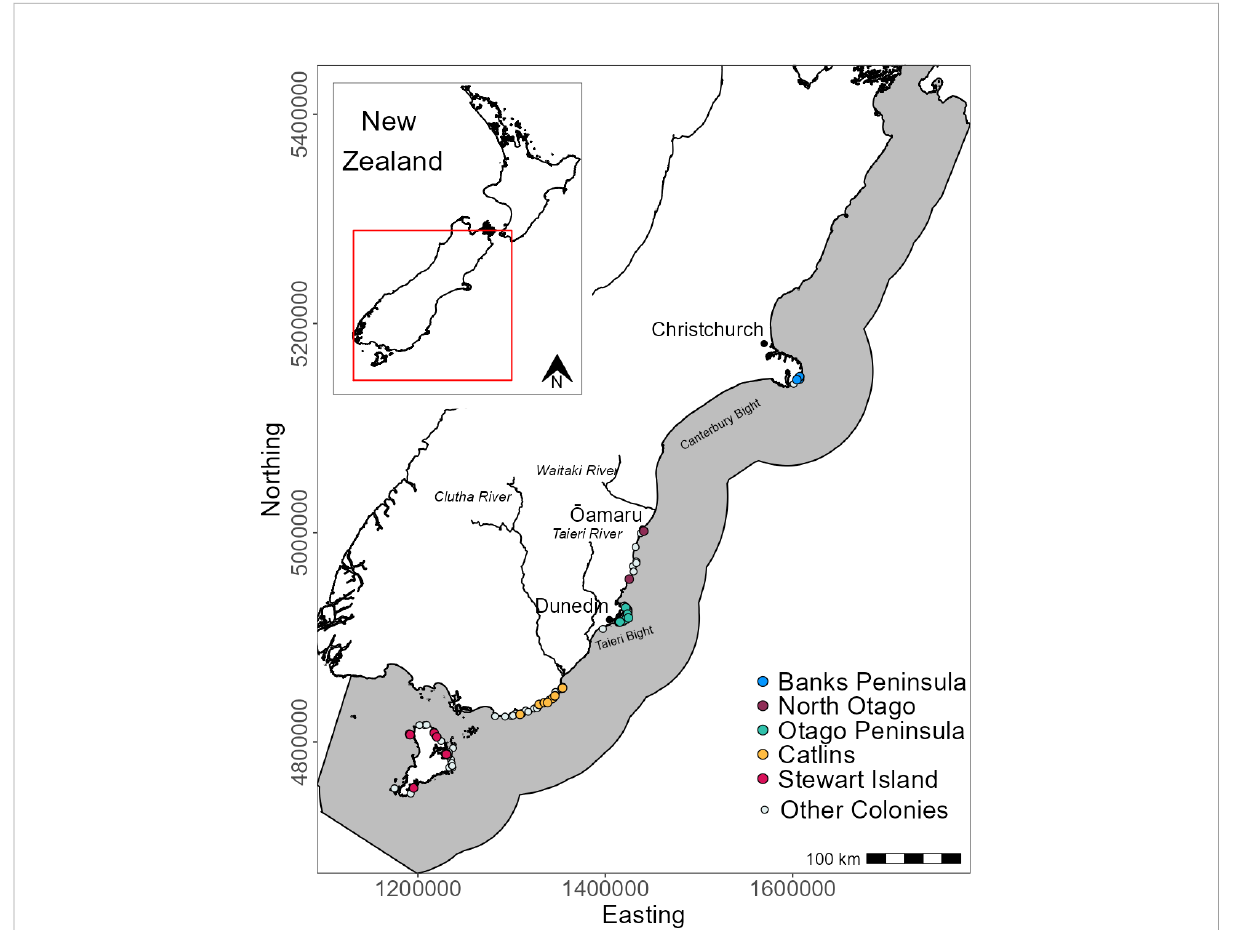
FIGURE 1 Distribution of breeding colonies across the South Island and Stewart Island, New Zealand and the GPS foraging trip data used in this study. Tracks and colonies are coloured by region. White circles denote colonies with at least one con fi rmed nest since 2003 but with no GPS tracking data. The grey area is the study